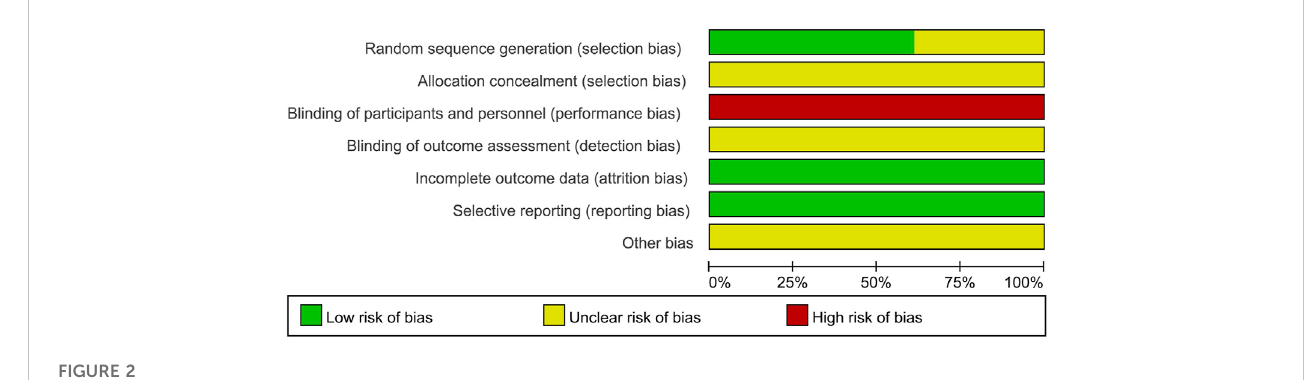
FIGURE 2 Risk of bias